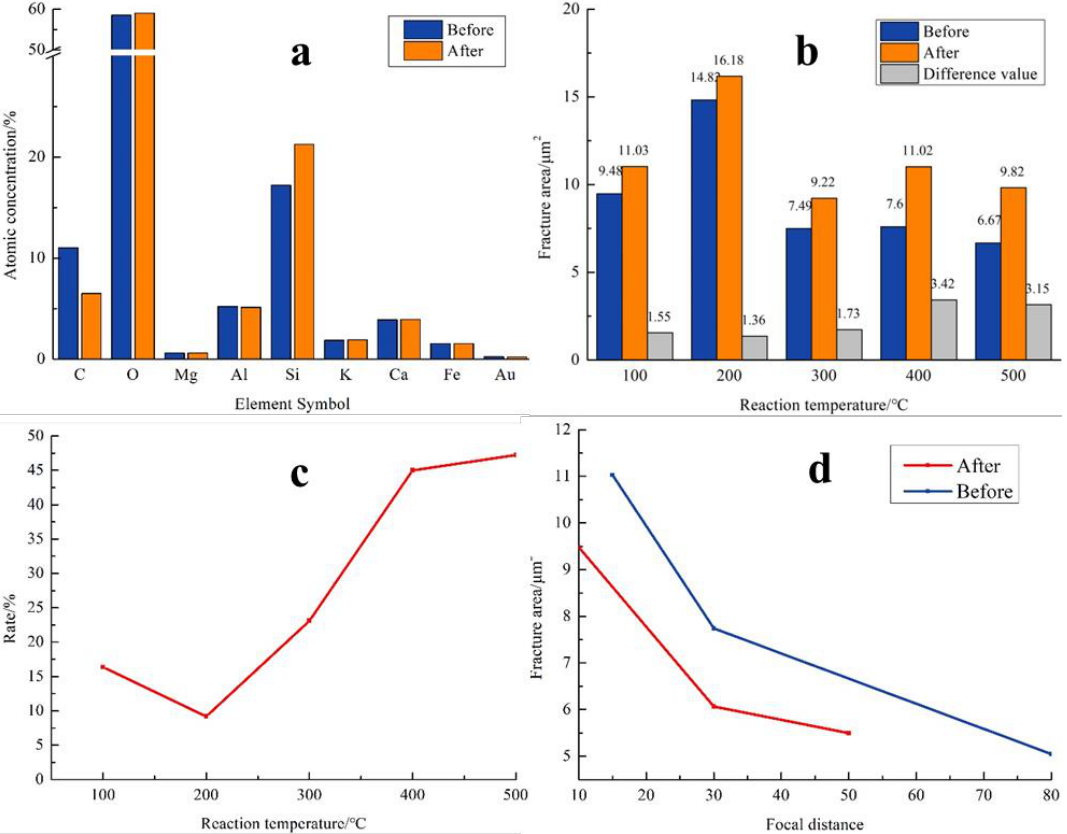
Figure 3. ( a ) Distribution of chemical elements in shale samples. ( b ) Histogram of shale fracture area change before and after Sc-CO 2 reaction. ( c ) Shale fractured area increment after Sc-CO 2 reaction. ( d ) Variation curve of fracture area on shale surface before and after reaction at 100 °C.